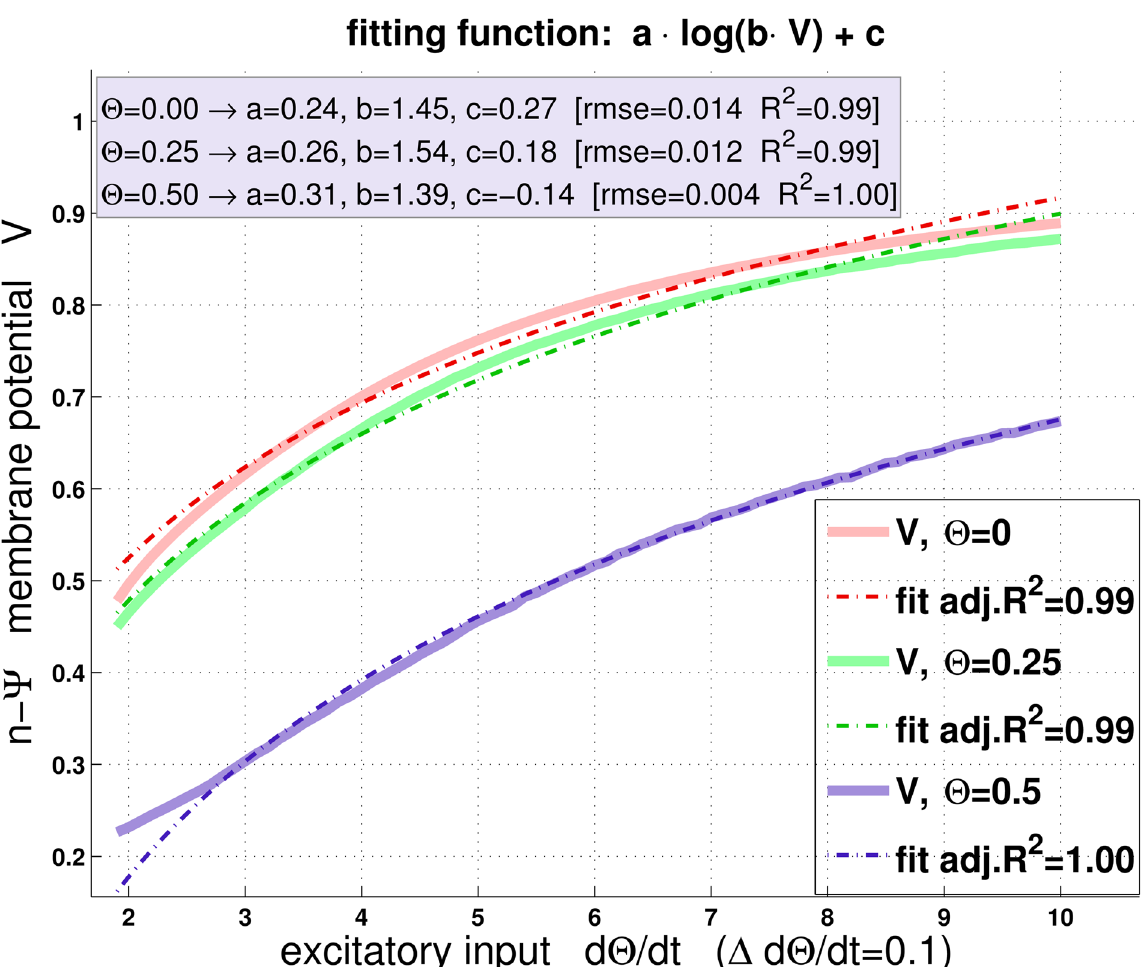
Fig 8. The n- ψ -model is consistent with logarithmic compression. A logarithmic compression of rate of expansion has been shown in refs. [22, 23]. Although logarithmic compression is not explicitly “ used ” as a computational feature in n- ψ , it nevertheless appears as a “ by-product ” : The light-colored solid curves show Eq (9) as a function of angular velocity _ Y (= excitatory input) for three constant values of angular size Θ (= inhibitory input). Notice that because of V inh (cid:7) V rest in Eq (9), increasing inhibition alone would be without effect (see Methods Section). The membrane voltage V of n- ψ could be reasonably well fi t by the logarithmic function a log( bV )+ c in the considered range of _ Y (dashed lines). The values from _ Y ¼ 0 to _ Y ¼ 2 were excluded from fi tting, due to initial transients. For computing V , _ Y was incremented linearly in steps of 0.1. Goodness-of- fi t measures and fi tting parameters are shown in the fi